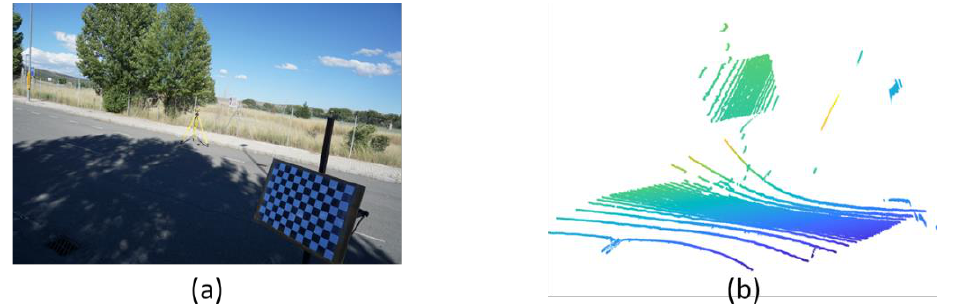
Figure 7. Calibration between the LiDAR sensor and the camera. ( a ) image acquired of the checkboard. ( b ) point cloud acquired of the checkboard.